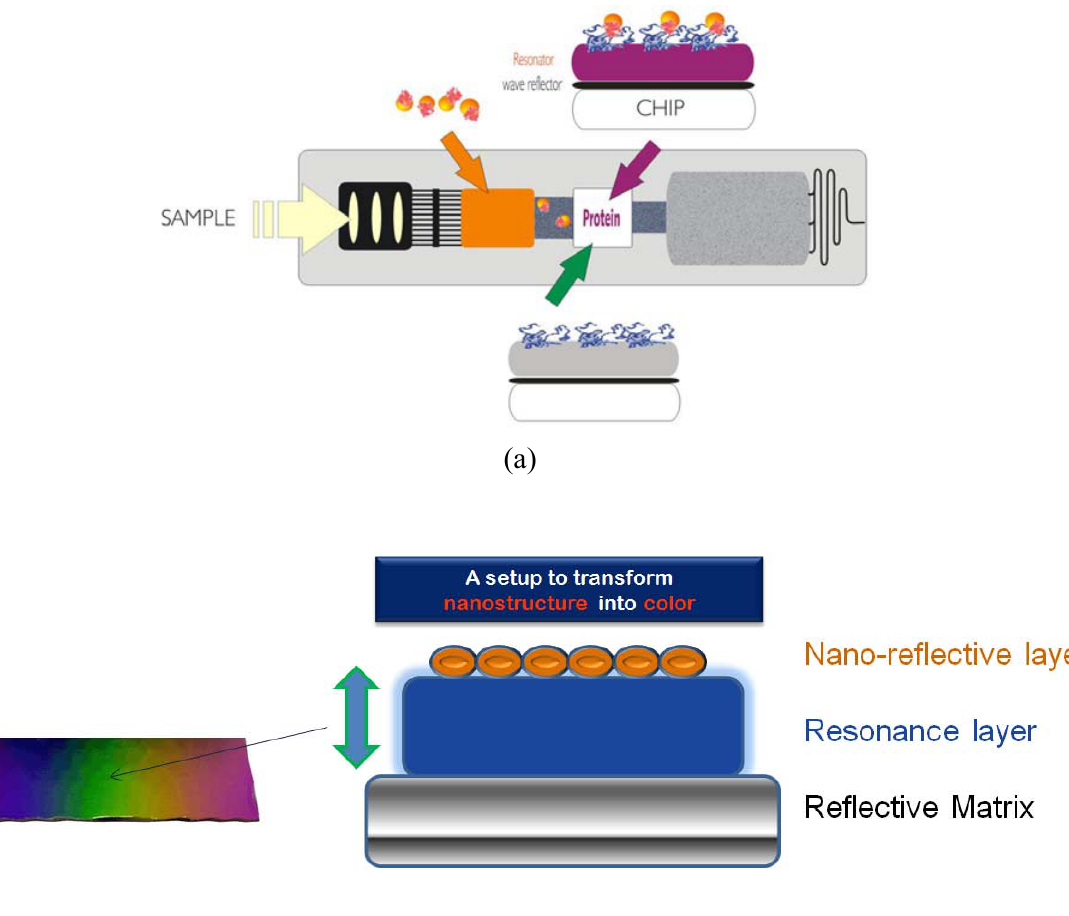
Figure 1. (a) Design and setup of resonance-color fluidic test sticks for proteins and DNA. (b) Scheme and setup of resonance-color